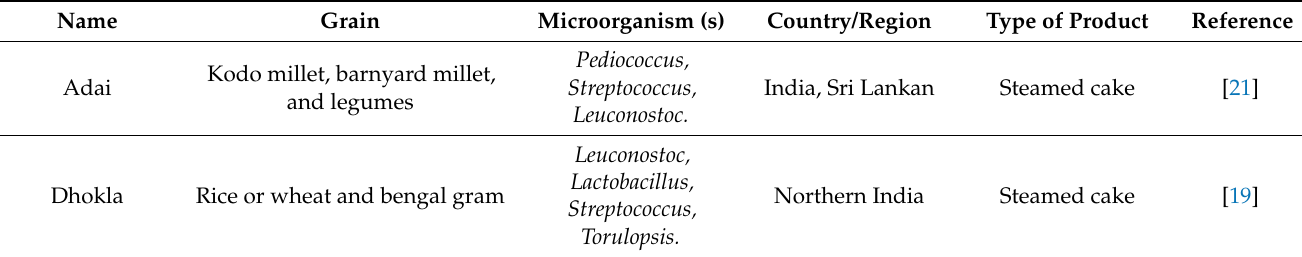
Table 1. Examples of lactic acid-fermented MG pancakes and bread used in different regions of the